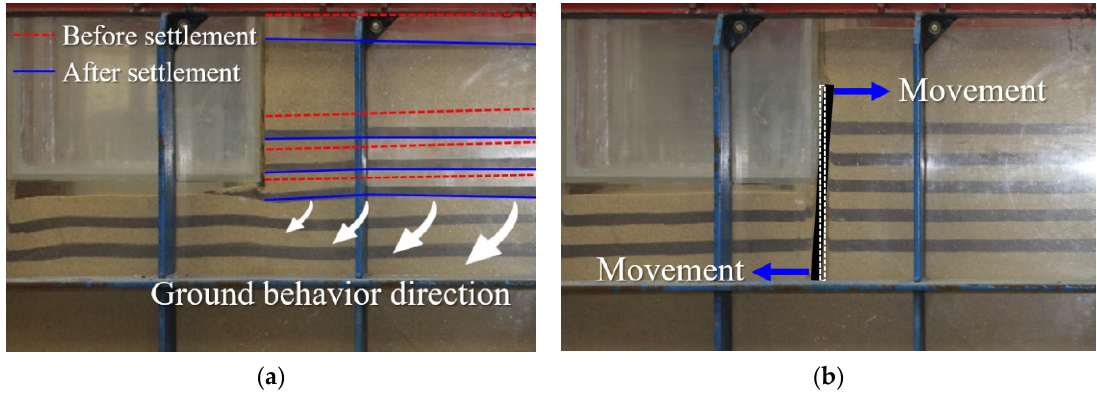
Figure 11. Visual analysis: ( a ) ground behavior; ( b ) SFP movement.